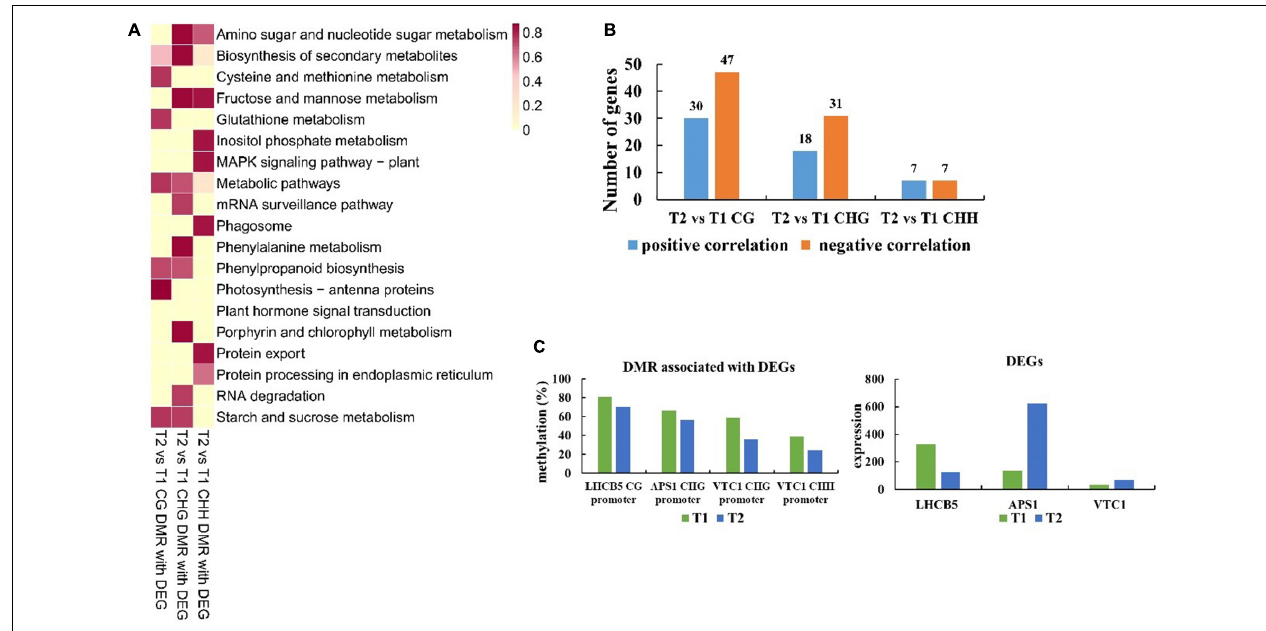
FIGURE 7 | Function, methylation, and expression analysis of differentially expressed genes (DEGs) associated with CG, CHG, and CHH DMR for T2 vs. T1. (A) Kyoto Encyclopedia of Genes and Genomes (KEGG) analysis of DEGs associated with CG, CHG, and CHH DMR for T2 vs. T1. Enriched KEGG pathways are shown via heatmap. The scale represents –log 10 p - value of enriched KEGG pathways. (B) The numbers of DEGs present a positive or negative correlation between methylation and expression levels. (C) Methylation and expression levels of specific genes between T2 and